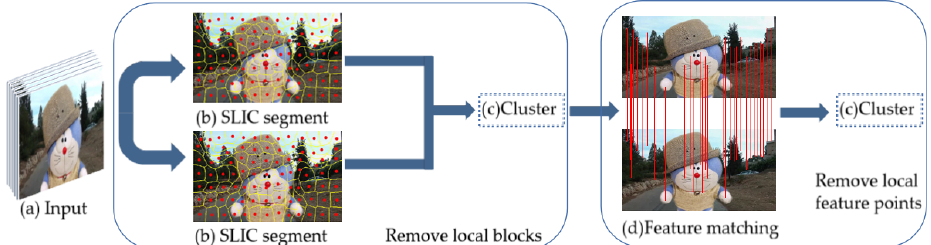
Figure 2. Our proposed method pipeline: the video input ( a ) is partitioned into the simple linear iterative clustering (SLIC) segment ( b ). The superpixel’s centroid motion is clustered, and feature points match between adjacent frames ( d ). The adaptive K-means clustering is applied to remove local feature points.